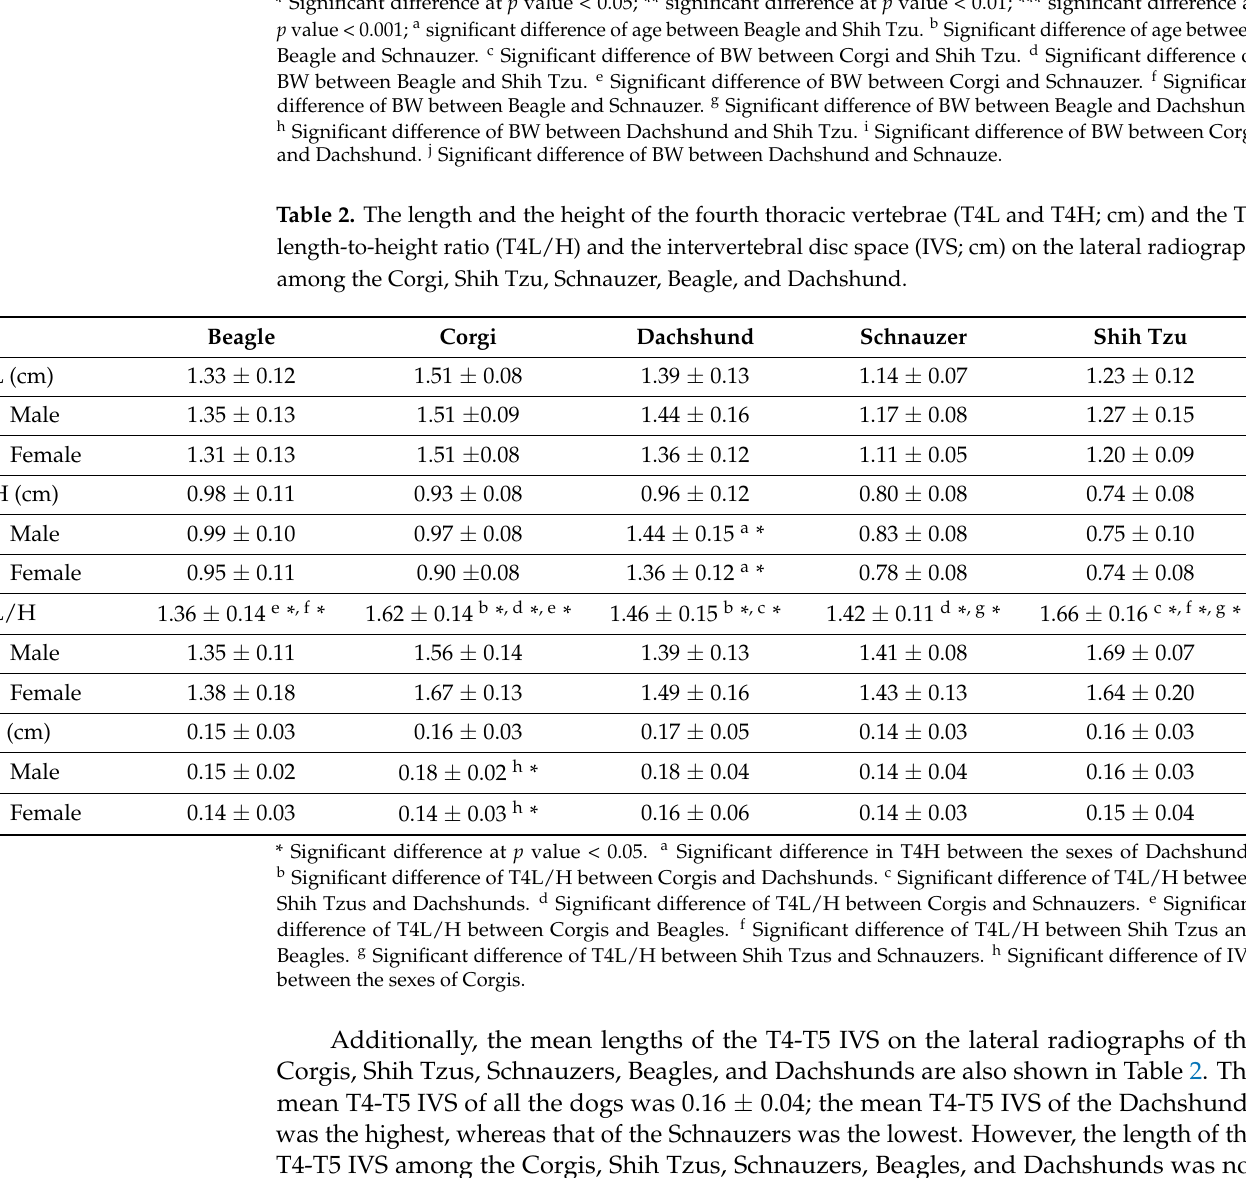
T4-T5 IVS among the Corgis, Shih Tzus, Schnauzers, Beagles, and Dachshunds was not significantly different ( p = 0.13). Furthermore, no statistical difference in the T4-T5 IVS was observed between the sexes, except for male Corgis, which had a wider IVS than female Corgis ( p =